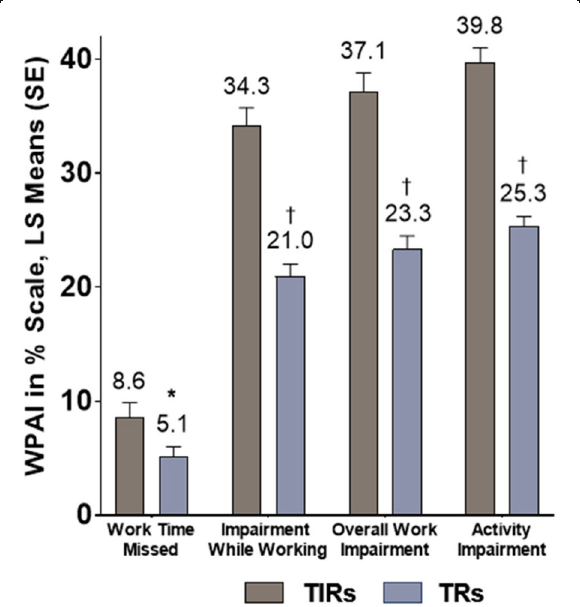
Fig. 4 Patient-reported work productivity and activity impairment according to patient response to triptan medication. * p < 0.05; † p < 0.001 for TIRs versus TRs using multivariable general linear model controlling for age, sex, migraine headache day frequency, comorbidities, duration of illness, preventive medication use, and migraine with or without aura. Note: Higher WPAI score indicates greater impairment. LS = least squares; WPAI=Work Productivity and Activity